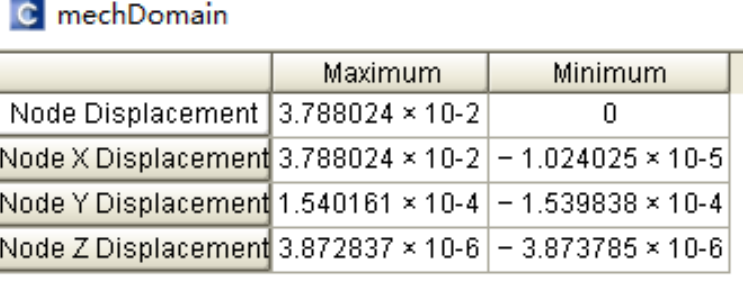
Figure 6. Static force analysis (single-stage beam).